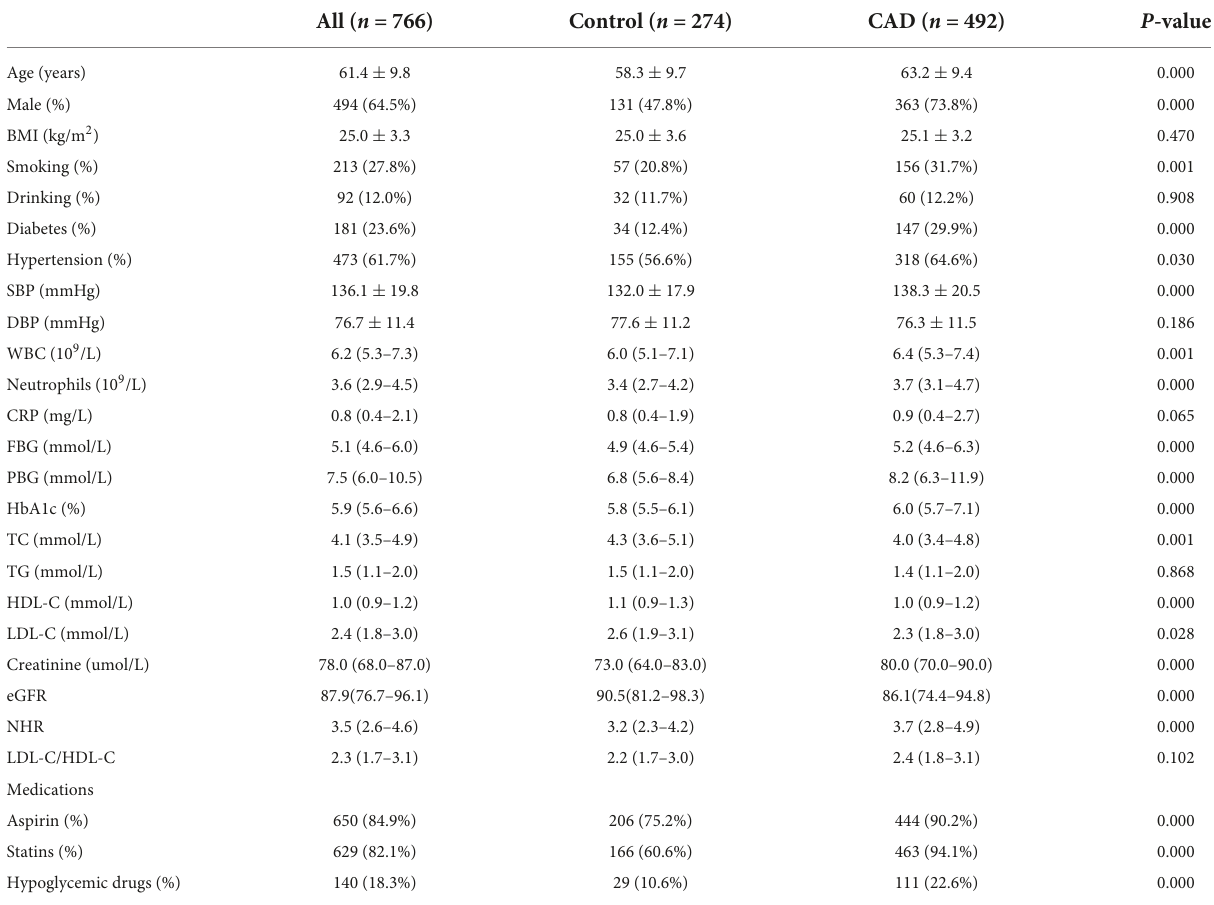
TABLE 2 Baseline characteristics of the study